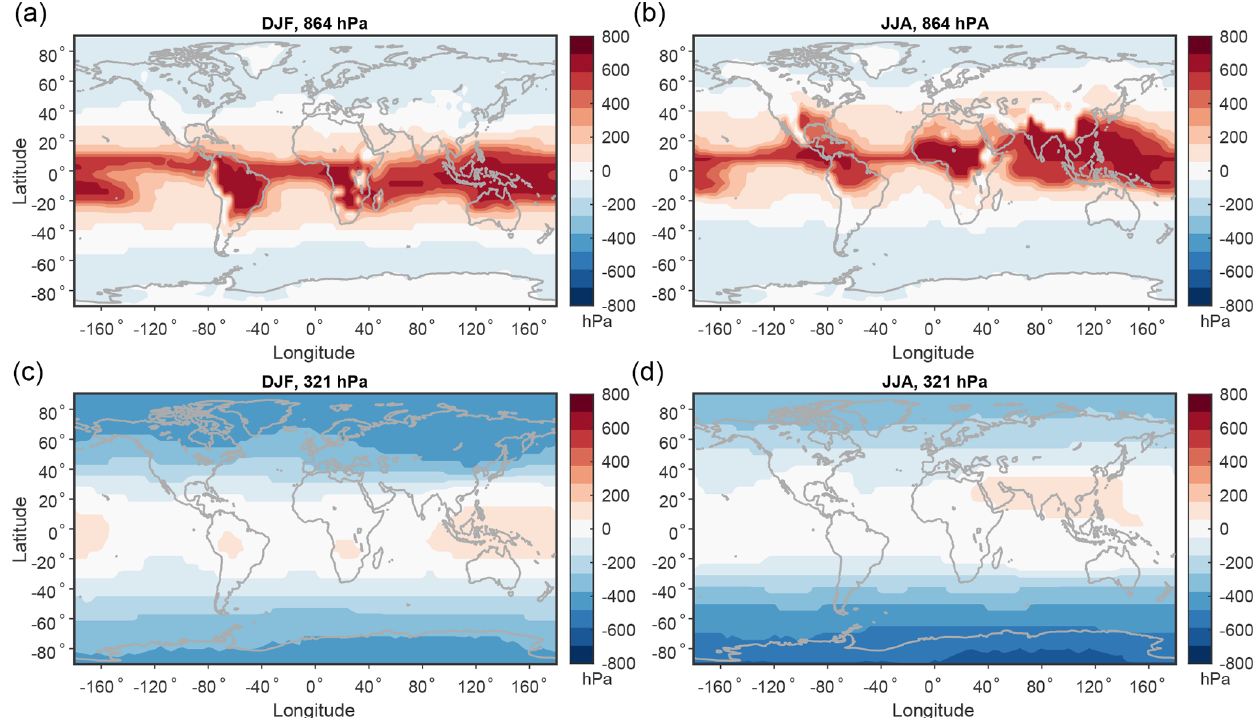
Figure 2. Visualization of vertical parcel motions in global three-dimensional MAPE calculations for different seasons. Shown is the original pressure minus reference pressure for parcels originating at (a, b) 864hPa and (c, d) 321hPa for (a, c) DJF and (b, d) JJA. Positive values imply ascent from the mean state to the reference state, and negative values imply descent from the mean state to the reference